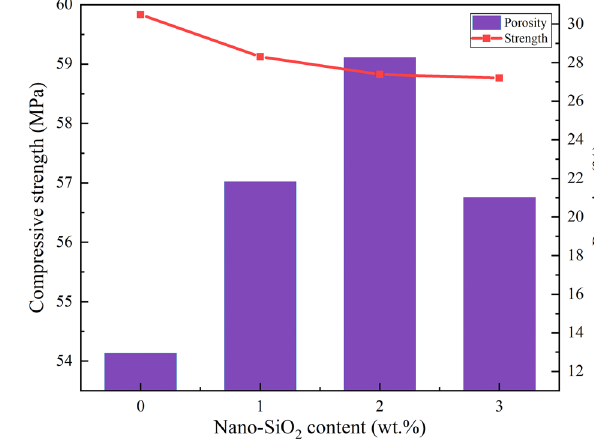
Figure 17: Relations between 28 days strength, porosity and nano - SiO 2 content ( slag/ fl y ash = 70/30 ) [ 98 ] .